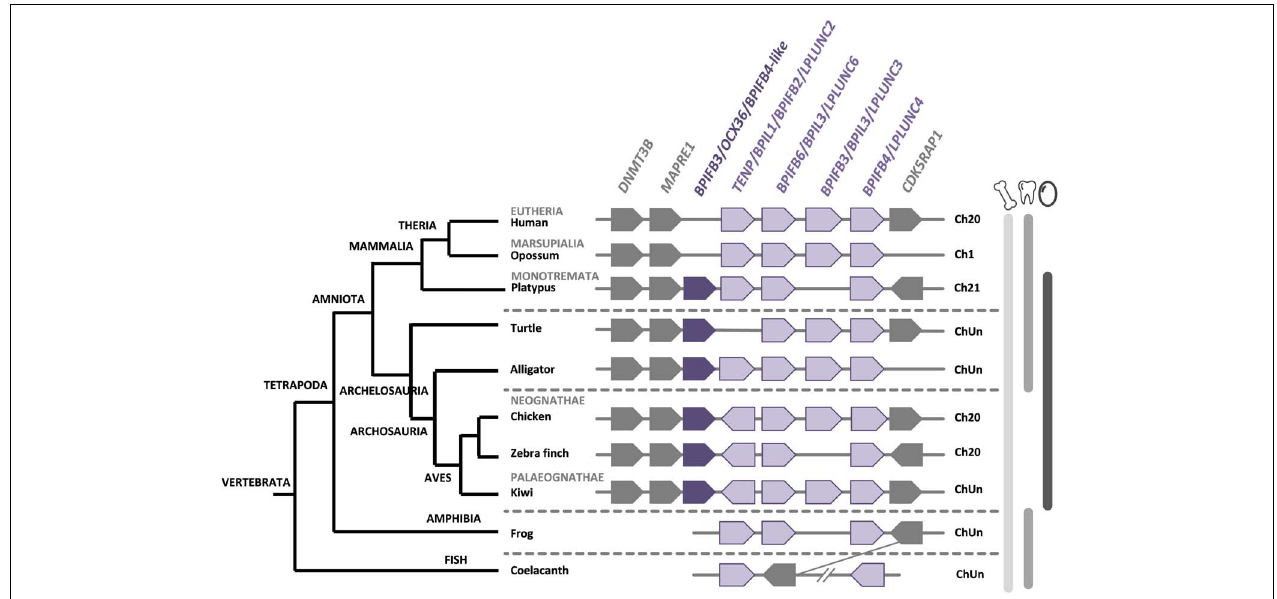
FIGURE 5 | Synteny of BPIFB3/OCX36 genes in birds and its relatives in vertebrates. The BPIFB3/OCX36 gene is represented by a dark purple box and its relatives are represented by light purple boxes. Flanking genes DNA (cytosine-5)-methyltransferase 3B ( DNMT3B ), Microtubule-associated protein RP/EB family member 1 ( MAPRE1 ) and Mitochondrial tRNA methylthiotransferase ( CDK5RAP1 ) are represented by gray boxes. ChUn, chromosome unknown. Gene IDs are listed in Supplementary Table 2 . The left part of the figure depicts the phylogenetic relationship between vertebrate species (adapted from www.tolweb.org and Kapusta et al.,